Question: Express in one sentence what the figure is showing.
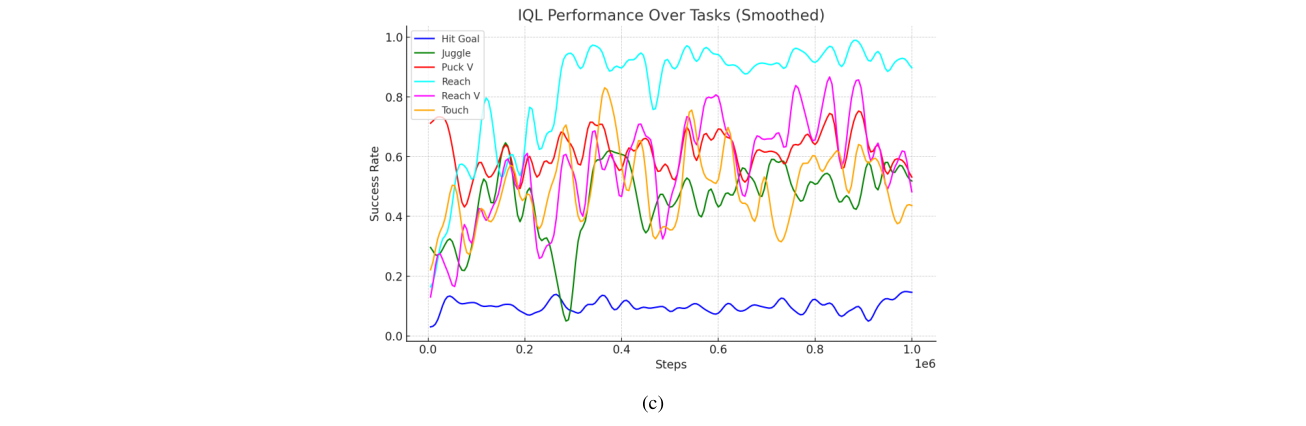
Answer: Robosuite Training curves. (a): Vanilla RL with PPO, following the implementation of CleanRL library [22]. (b) Behavior Cloning with data collected the ”expert” policy (a trained PPO policy). (c) IQL [23] using the same offline data, using asymmetric τ set to 0.6.